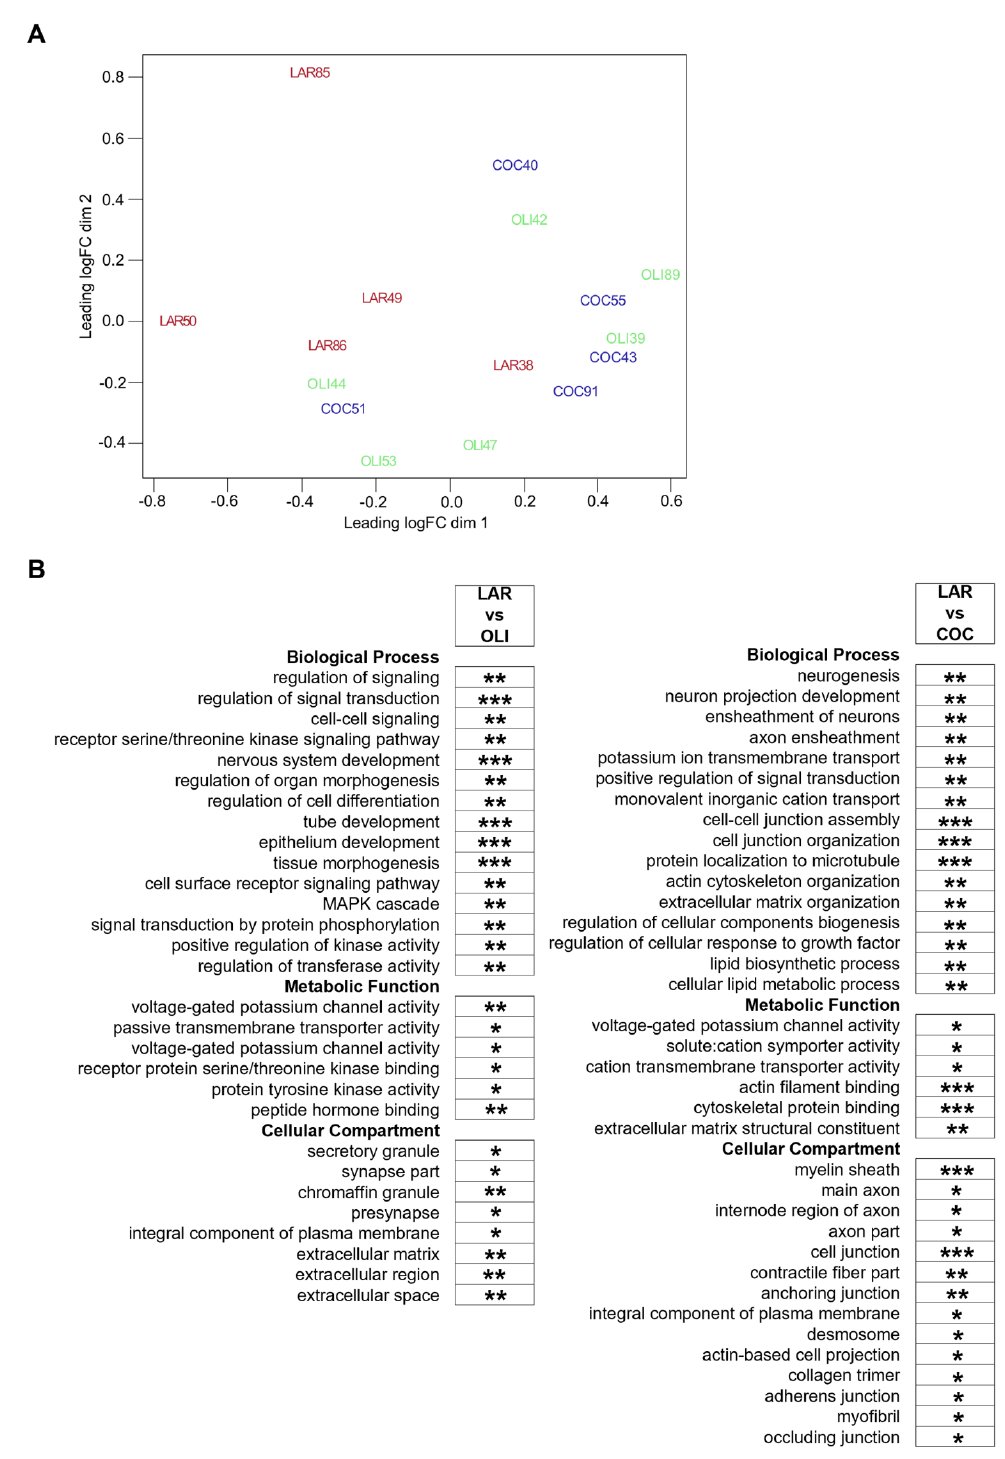
Figure 6. ( A ) Multidimensional scaling diagram of FC samples indicating the groupings obtained from the multivariate analysis. ( B ) Functional enrichment analyses performed on differentially expressed genes at 5% FDR to identify GO terms pertaining to Biological Process, Metabolic Function, and Cellular Compartment in the frontal cortexes of juvenile Iberian pigs using the Database for Annotation, Visualization and Integrated Discovery software version 6.8. * p ≤ 0.05, ** p ≤ 0.01, *** p ≤ 0.001. COC, coconut oil diet; FDR, false discovery rate; LAR, lard diet; OLI, olive oil